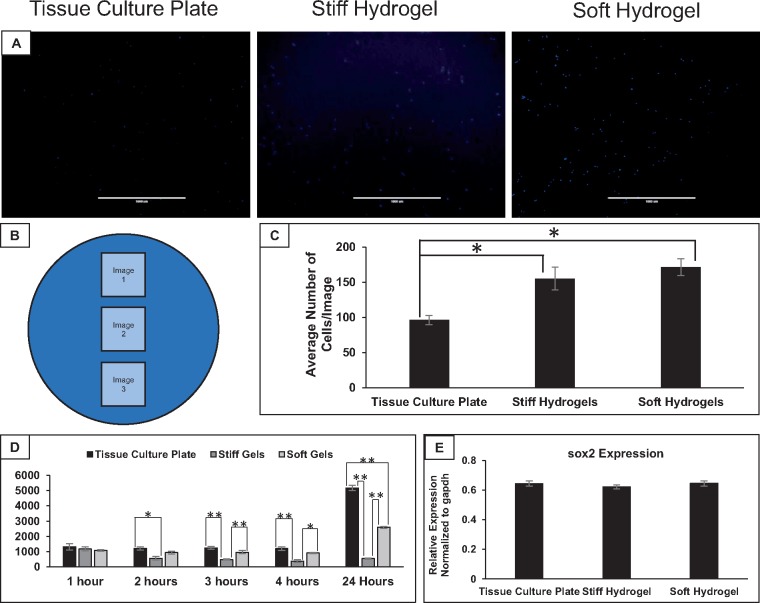
hMSCs attach more readily to hydrogels, but display decreased proliferation, despite equal expression of sox2. (A) Example images of DAPI stain hMSCs 18 hours post-seeding on the different elasticity conditions. (B) Schematic representation of imaging method used for attachment studies. Three images were taken (as shown in panel A) of each sample, with three samples per surface. (C) Results of ImageJ quantification of nuclei per image. (D) Results of AlamarBlue analysis of hMSCs cultured on each surface. AlamarBlue was added after cells were cultured for 72 hours, and timepoints shown in graph represent hours after AlamarBlue introduction. (E) Quantitative reverse-transcriptase PCR analysis of sox2 expression in hMSCs cultured on each elasticity condition for 72 hours. *Tukey HSD resulting P < 0.05. **Tukey HSD resulting P < 0.01. n = 3 for C, D and E. Scale bars: 1000 µm